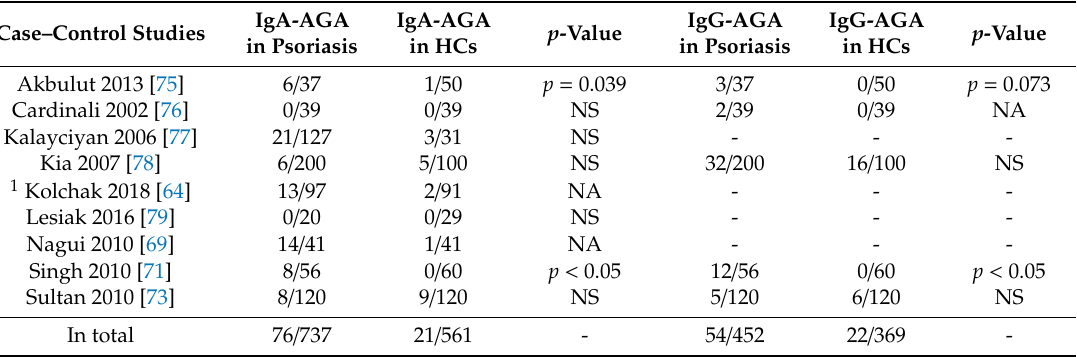
Table 1. Case–control studies estimating the prevalence of IgA-AGA and IgG-AGA in patients with psoriasis and HCs. Results are presented as “number of seropositive individuals” / “number of individuals tested”. HCs: healthy controls, Ig: immunoglobulin, AGA: antigliadin antibody, NA: not available, NS: not